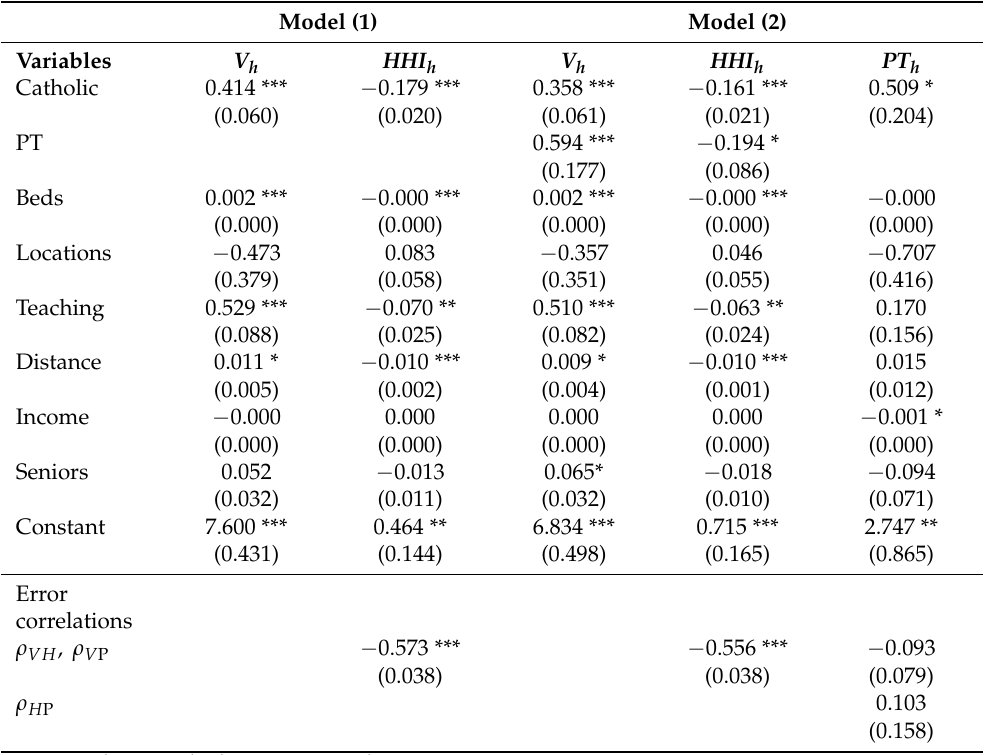
Table 2. The association of Catholic ownership and part-time CMO positions with operational strategies.